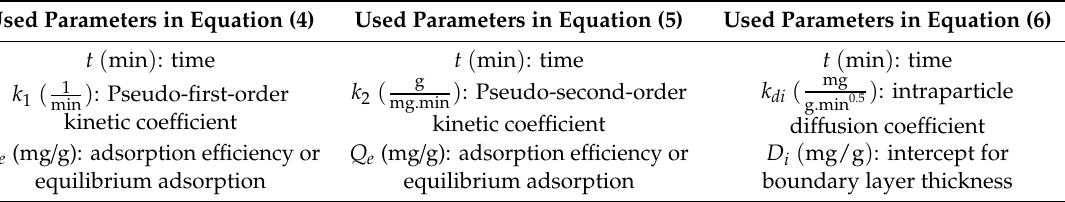
Table 1. Parameters used in Equations (4) to (6).